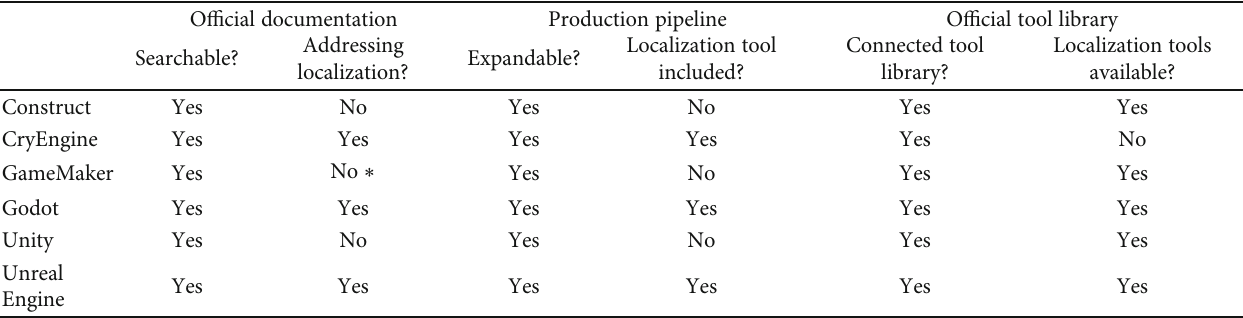
Figure 6: A screenshot of the localization tool in Godot. Table 3: Summary of localization tools in general purpose game engines.